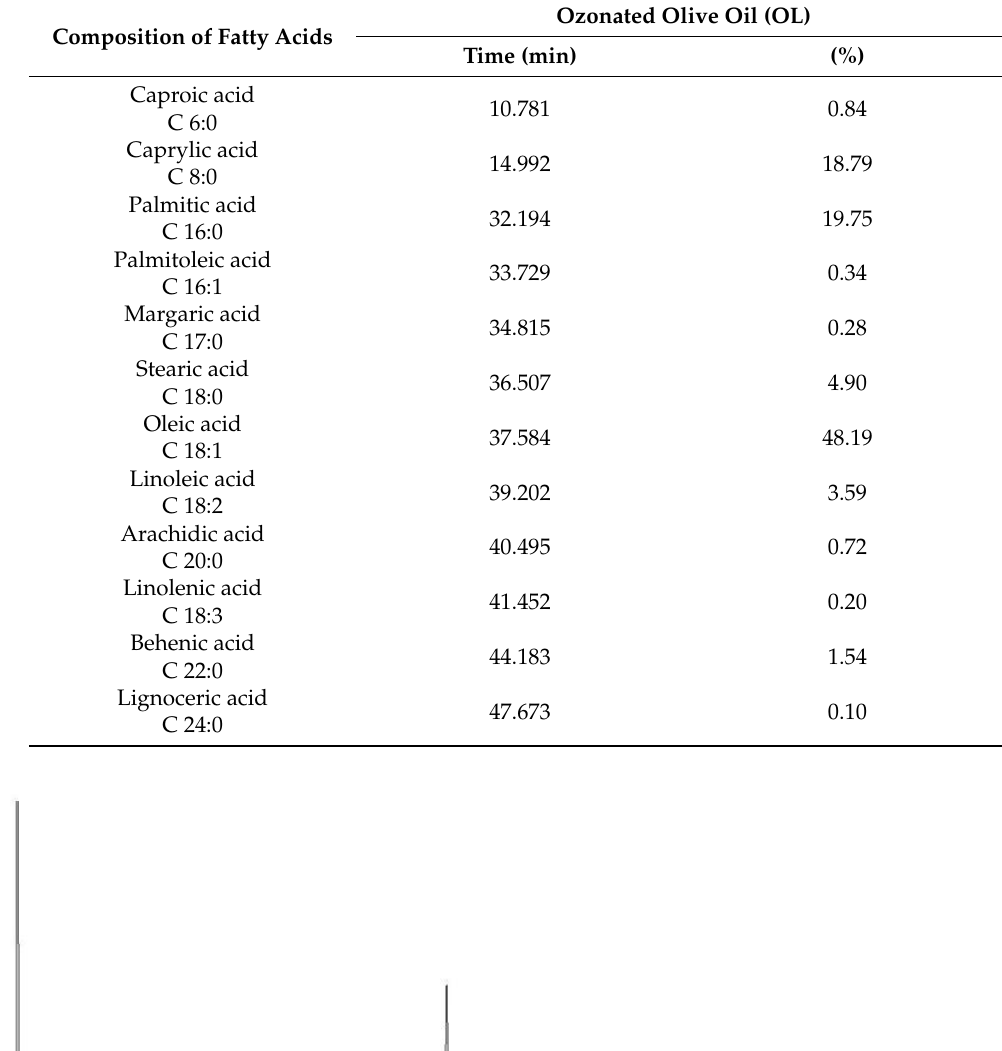
Table 1. Fatty acids identified in the ozonated olive oil (OL) using GC.